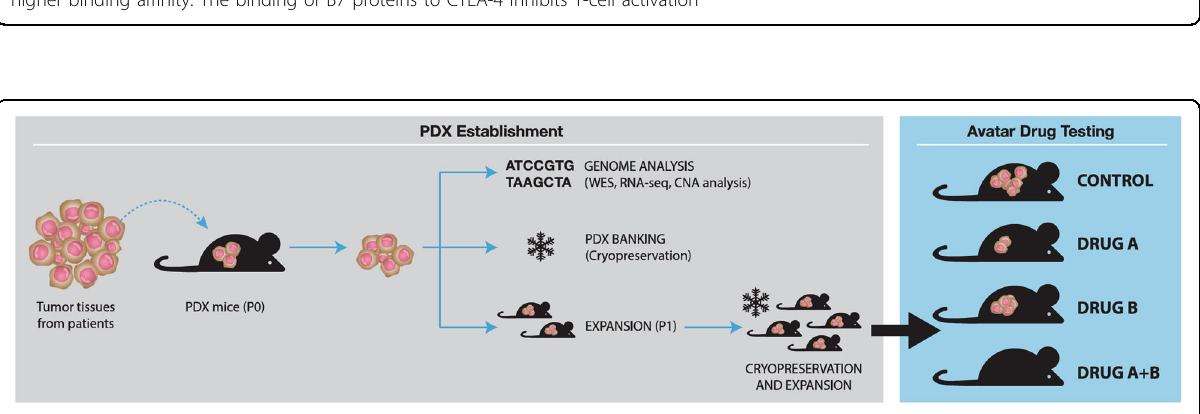
Fig. 2 Generation of PDX models for chemotherapy. Tumor tissues from cancer patients are implanted into immunode fi cient mice (P0) subcutaneously or orthotopically. After the growth of tumor tissues in P0 mice, these tissues are used for genomic analysis such as whole exome sequencing (WES), RNA sequencing (RNA-seq) and copy number alteration (CNA) analysis and can be preserved or reimplanted into new mice for tumor cell passaging. After more expanding of these tumor xenografts, in vivo drug response testing can be performed in these